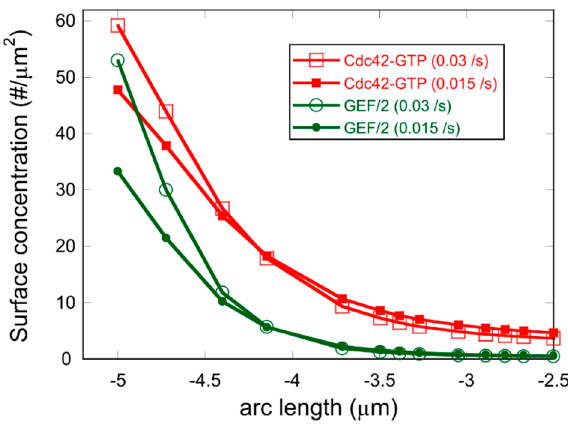
Figure 7. Plot of Cdc42-GTP and GEF concentration gradient when the rate of GAP II recruitment to the cell tips is 𝑘 (cid:2873)(cid:3041) = 0.03 /𝑠 (empty symbols) and for the same parameters with reduced rate of 𝑘 (cid:2873)(cid:3041) = 0.015 /𝑠 (solid symbols), as might occur in rga4 Δ cells. Other parameters are the same as Table 1 except 𝑘 (cid:2929)(cid:2911)(cid:2930) = 450 /μm (cid:2870) , such cases result in BPO oscillations (see Figure 5B). This plot shows the concentration profiles at the dominant tip ~ 20 s after Cdc42-GTP tip concentration peaks, and after at least 1000 s of simulation time. The half-widths are larger with reduced GAP II recruitment rate: An exponential fit to the Cdc42-GTP profile gives a decay length 0.64 ± 0.01 µ m and 0.72 ± 0.01 µ m, respectively. The left-most point on the x axis corresponds to the left tip, as in Figure 2.